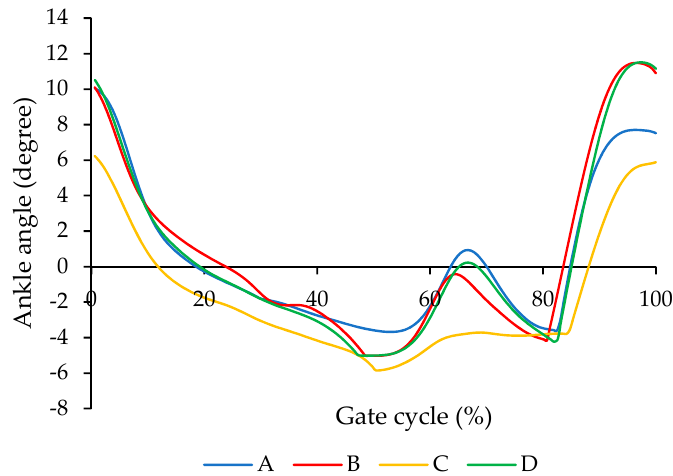
Figure 12. Comparison of the ankle angle for each trial for different conditions including (A) subject with bare foot, (B) subject wearing conventional HAFO with no spring, (C) subject wearing conventional Stainless Steel-based HAFO, and (D) subject wearing NiTi spring.